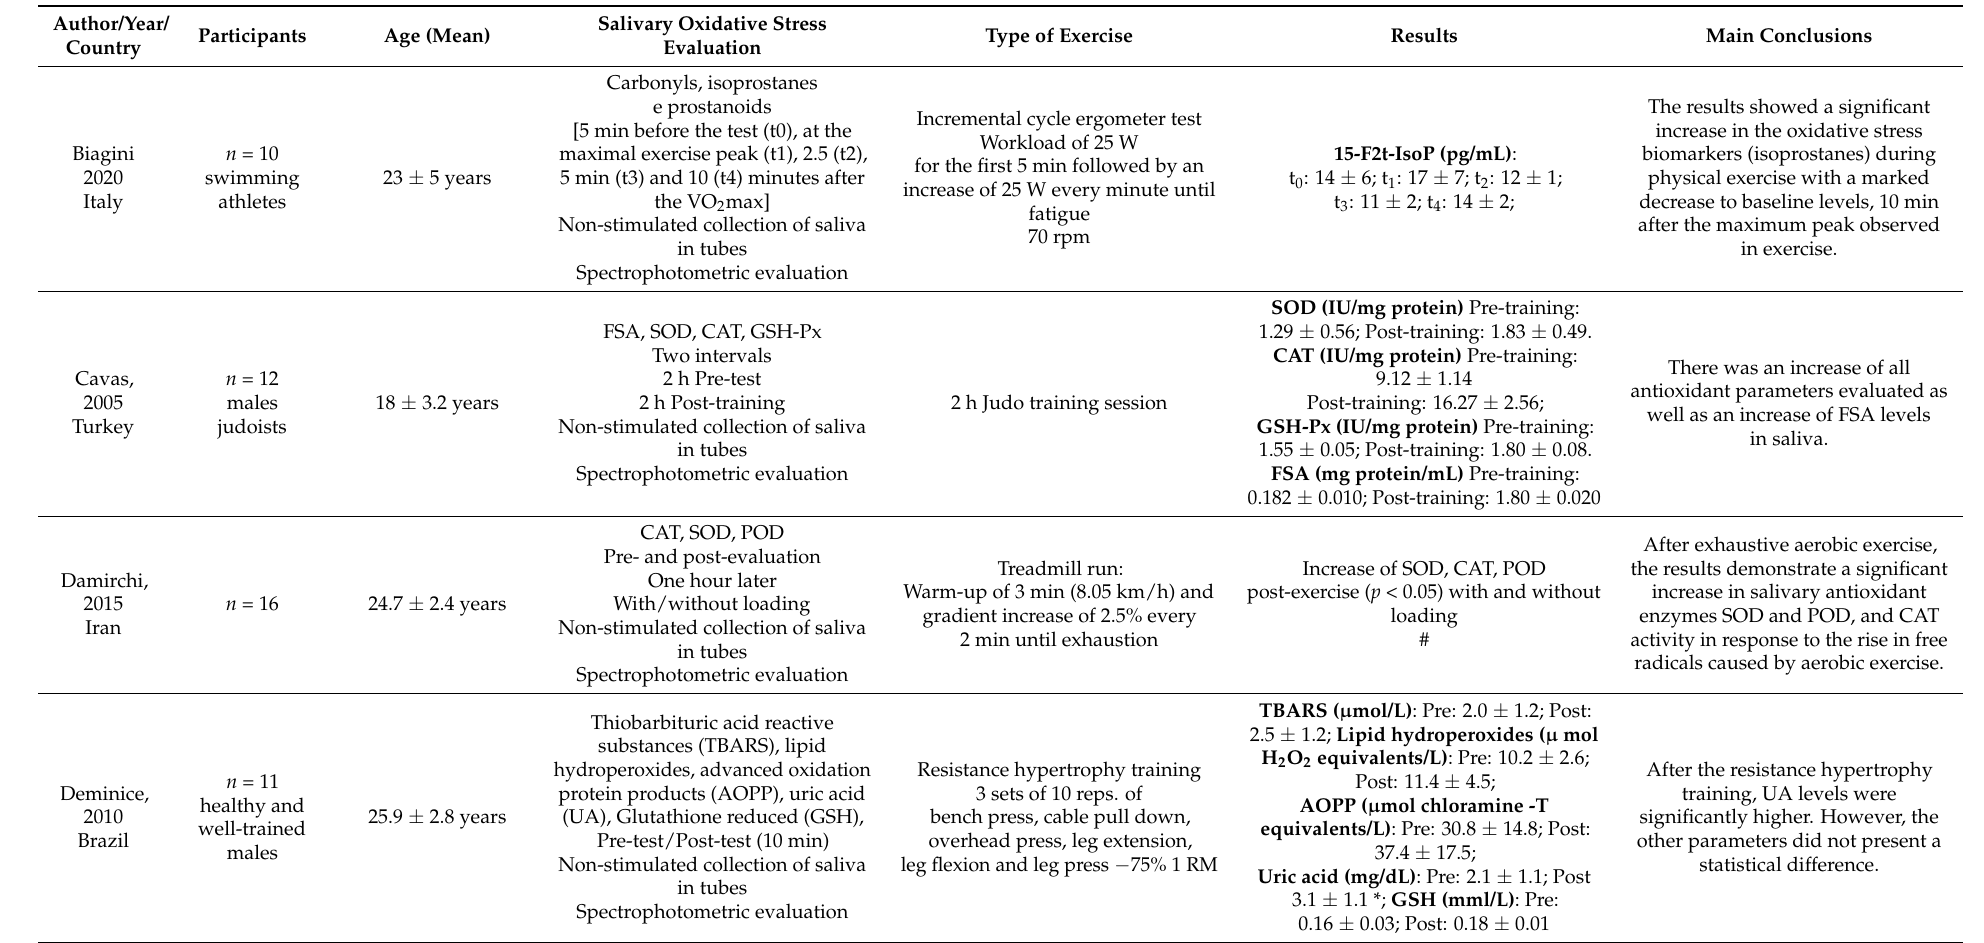
Table 1. Summary of the individual studies’